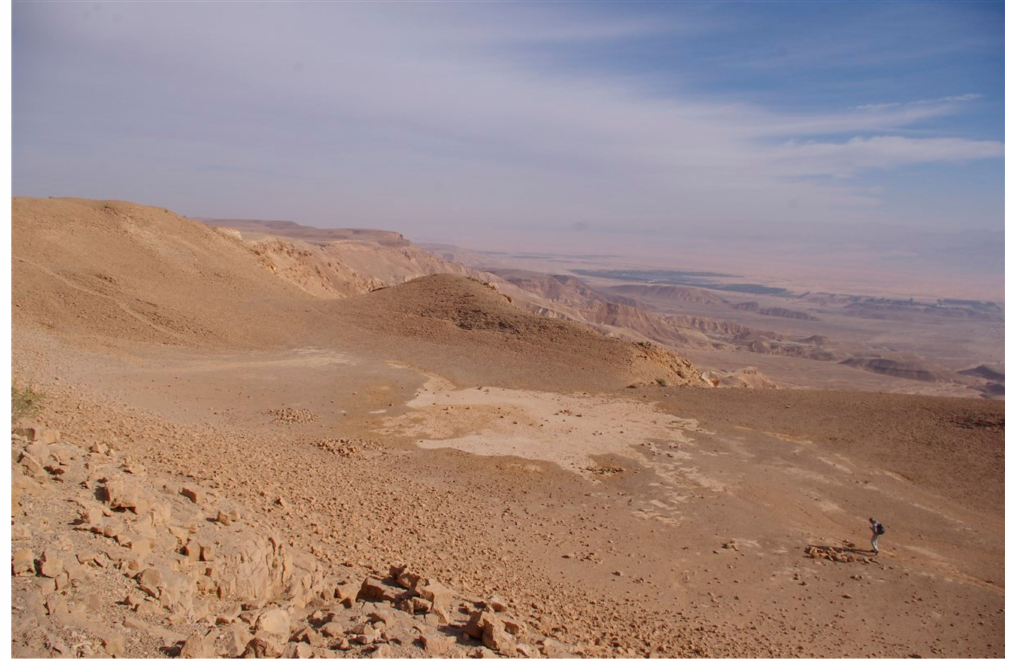
Figure 8. Re’u’el Playa (Qa Re’u’el), an eastern site. Notice the Shaharut Cliff’s edge at the right side of the playa. Picture taken by Ilan Stavi.